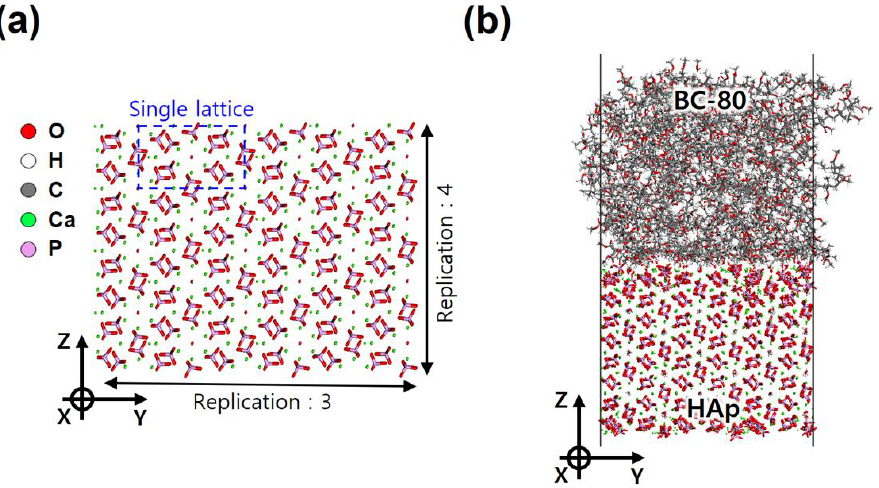
Figure 2. Bilayer model of the HAp and BC models. ( a ) HAp substrate with (110) surface and ( b ) the configuration of the HAp/BC bilayer, at the crosslinking ratio of